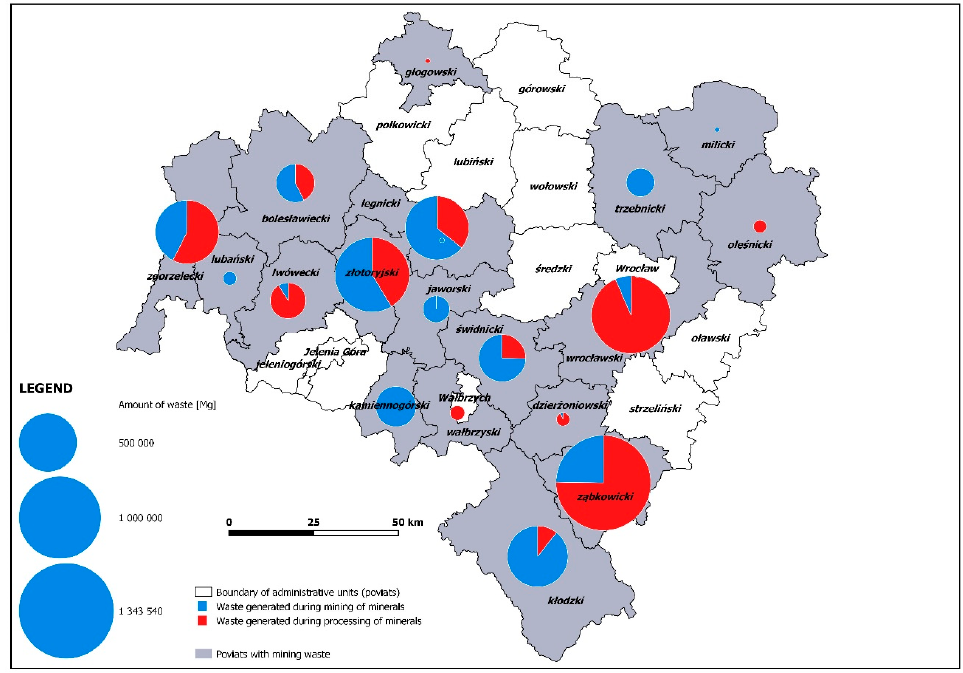
Figure 3. Waste generated in the mining of rock raw materials in the Lower Silesia region, classified by type of waste, in the years 2010–2016 [Mg].